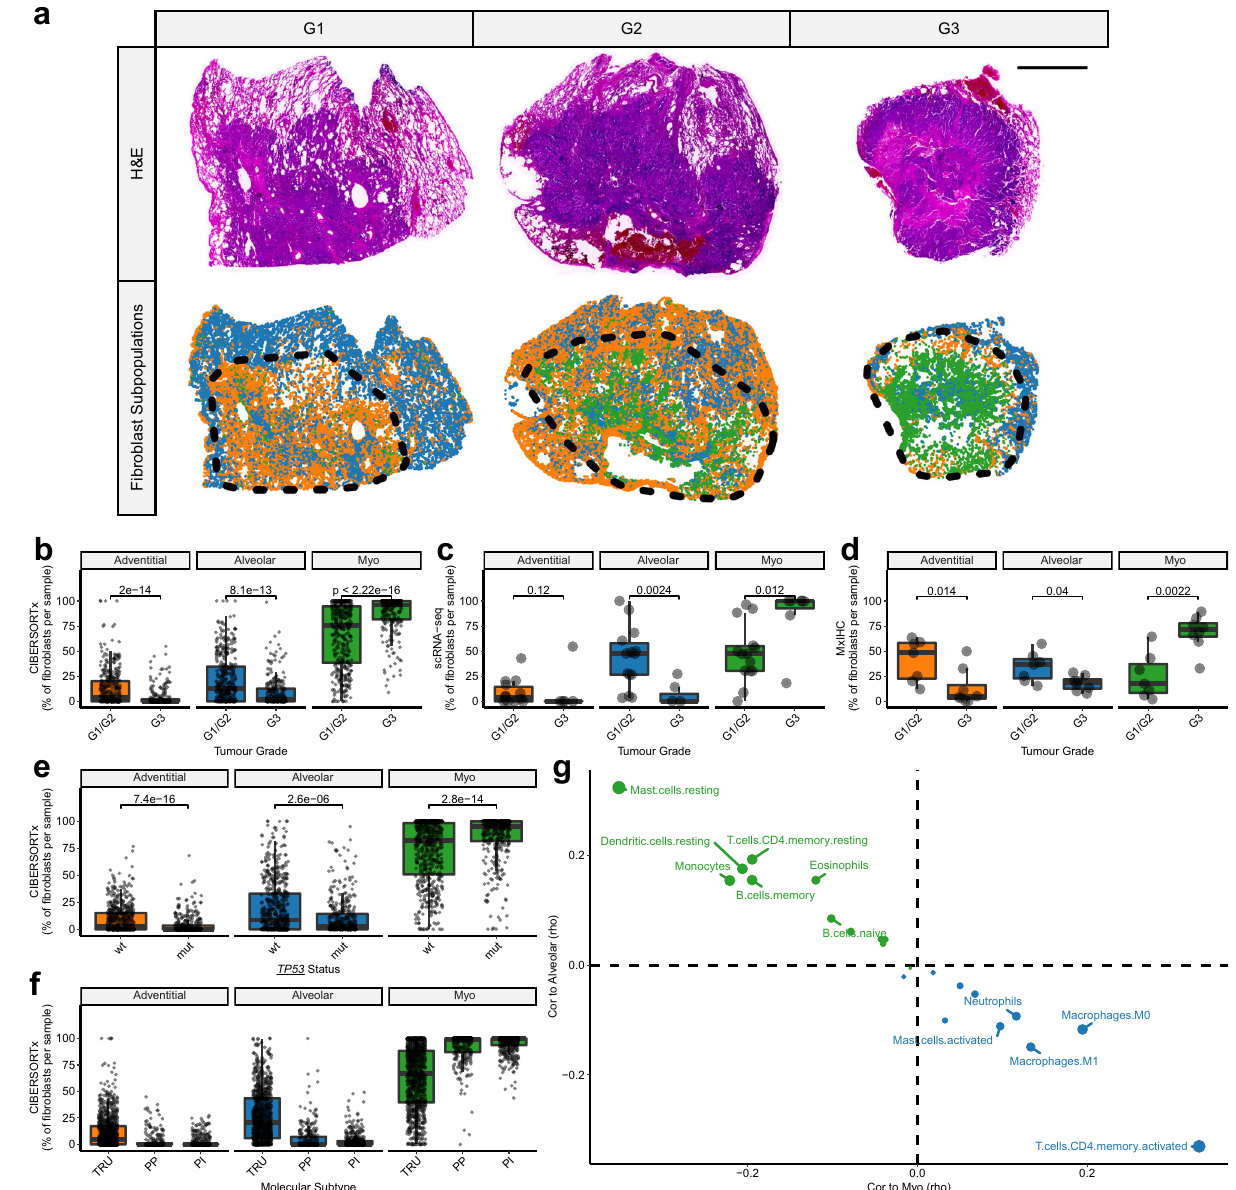
Fig. 7 | MxIHC and digital cytometry shows fi broblast subpopulations are associated with morphological, molecular and immunological features of LUADtumours.a RepresentativeimagesfromwholeslidemxIHCanalysisofLUAD tumours with varying grades (G1=well differentiated [ n =1], G2=moderately dif- ferentiated[ n =6]andG3=poorlydifferentiated[ n =8]),showingH&Estainingand point pattern plots representing the spatial distribution of different fi broblast subpopulations (measured by histo-cytometry analysis of mxIHC data). The scale bar represents 4mm and the black dotted line demarcates the tumour region in each tissue section. b Boxplots showing the relative abundance of fi broblast sub- populations in well/moderately differentiated LUAD tumours compared to poorly differentiated,measuredbyCIBERSORTxdigitalcytometry.Wilcoxonsigned-ranks test ( n =375 [G1/G2], 248 [G3]; from two independent datasets; 25,53 data from each individual dataset is shown in Supplementary Fig. 7a). c As per b , measured by scRNA-seq.Wilcoxonsigned-rankstest( n =14[G1/G2],7[G3]). d Asper b ,measured by mxIHC. Wilcoxon signed-ranks test ( n =7 [G1/G2], 8 [G3]). e Boxplots showing the relative abundance of fi broblast subpopulations in LUAD tumours grouped by